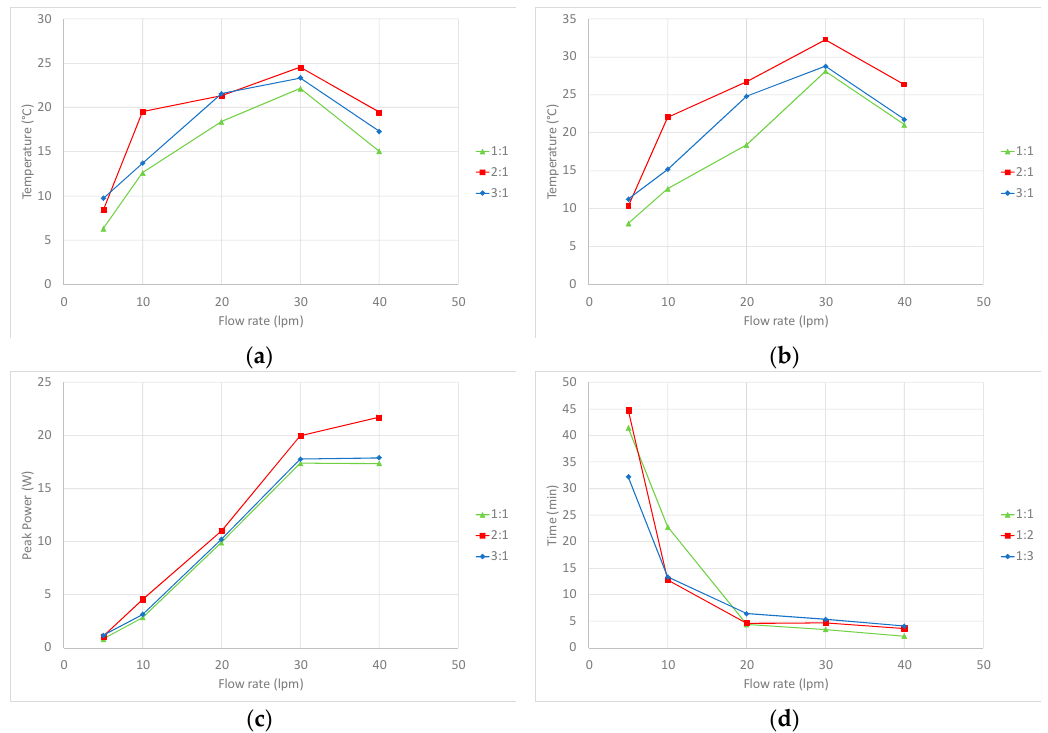
Figure 5. Performance of each SIM: vermiculite ratio over a 45-min period at each flowrate showing ( a ) mean outlet temperature uplift; ( b ) peak outlet temperature uplifts; ( c ) peak power and ( d ) time to peak power.